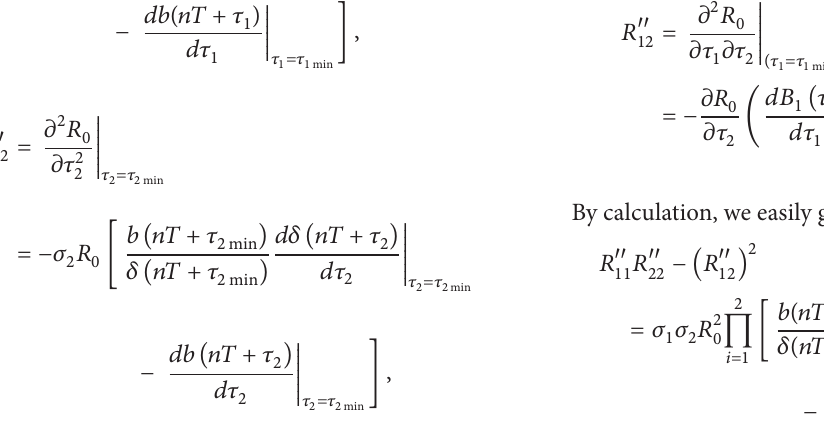
Figure 3: The effects of the impulsive period 𝑇 , the releasing quantity 𝜎 1 , the killing rate 𝑝 1 , and the death rate 𝑏(𝑡) on the threshold condition 𝑅 0 . The baseline parameter values are as follows: = 5 . (a) The effect of the period 𝑇 on 𝑅 𝑇 = 5 , 𝜎 1 (d) the effect of death rate 𝑏 0 on 𝑅 0